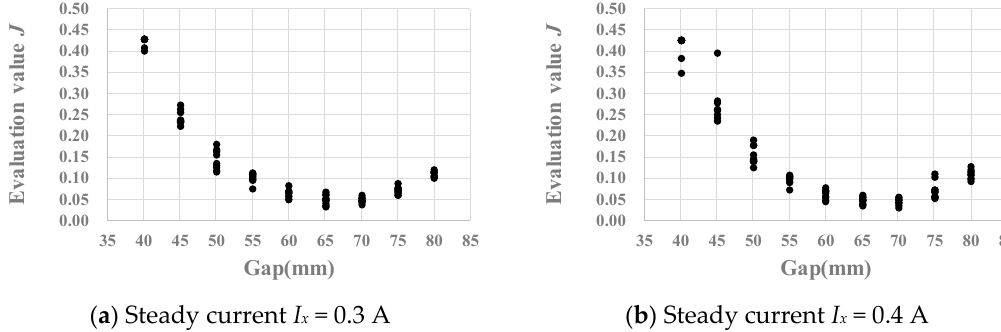
Figure 6. Evaluation value vs. gap in consideration of changed horizontal steady current.